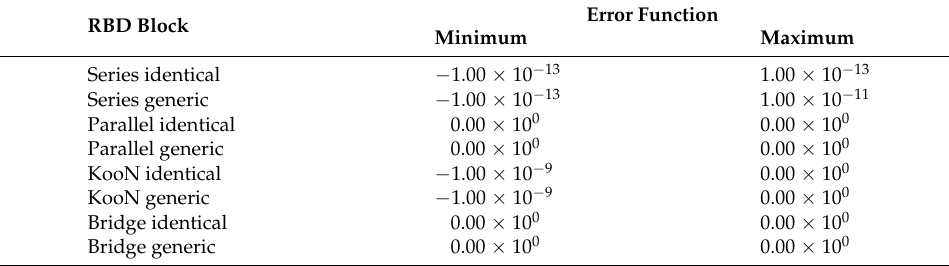
Table 3. Error function between librbd and SHARPE